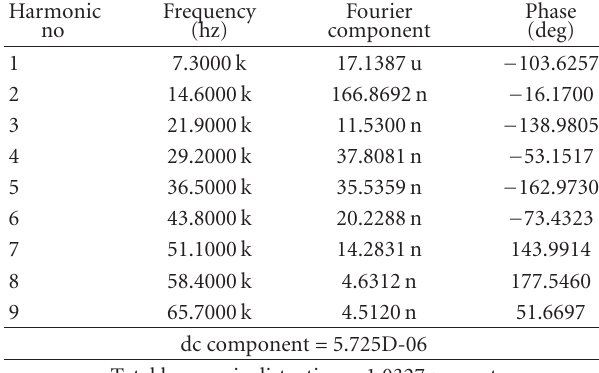
Table 3: Total harmonic distortion analysis of I o 2 in Figure